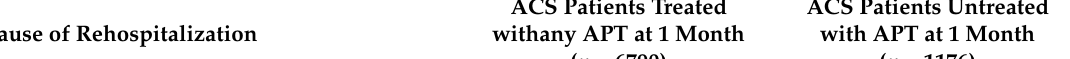
Table 3. Rehospitalizations during follow-up in the acute coronary syndrome population stratified by antiplatelet therapy at one